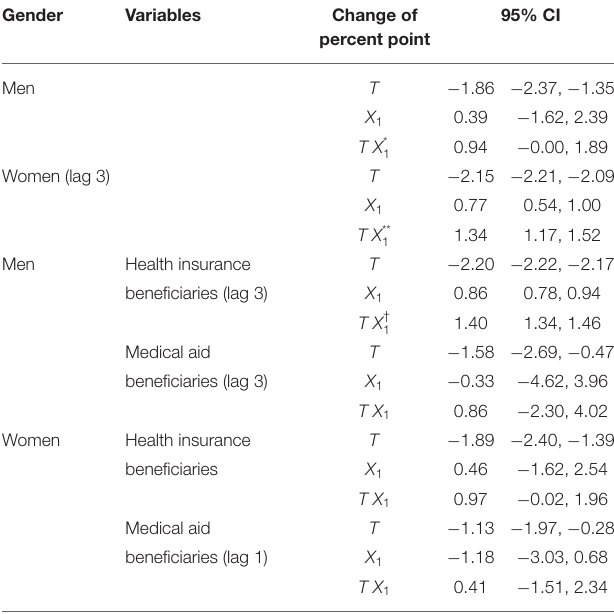
TABLE 5 | Percent point changes in unvaccinated rates by gender and type of health coverage. Gender